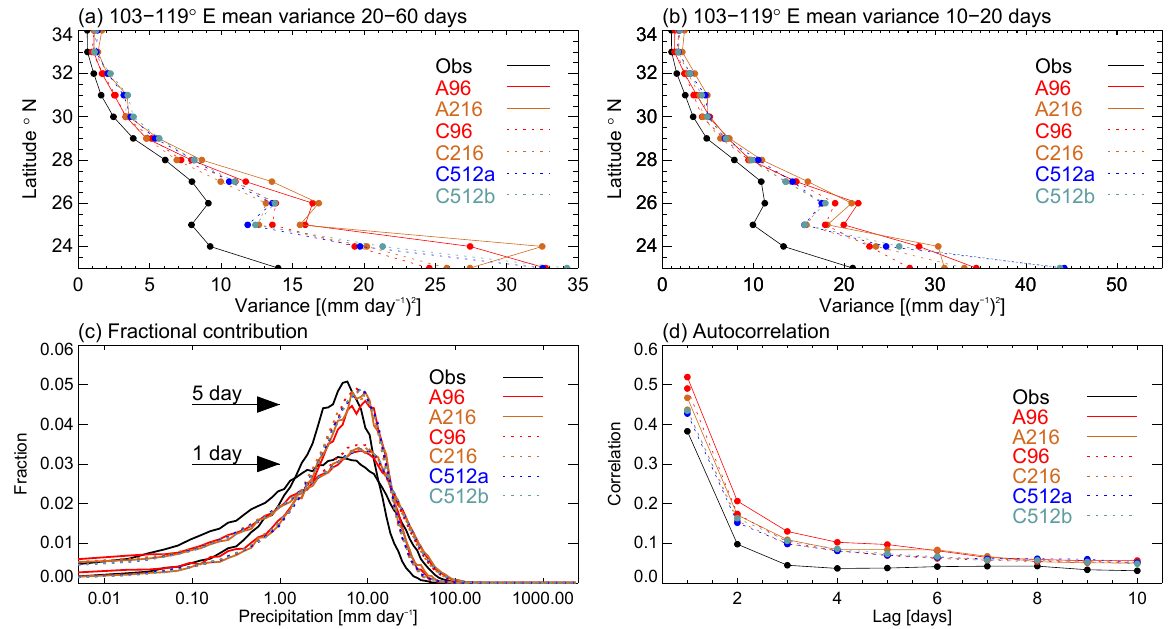
Figure 5. (a, b) Observed and simulated meridional profiles of the intraseasonal variance of precipitation averaged between 103 and 119 ◦ E for (a) 10–20-day and (b) 20–60-day filtered variability. (c, d) For precipitation averaged over southern China (22–32 ◦ N, 103–119 ◦ E) the (c) observed and simulated spectra of fractional contributions to daily and 5-day precipitation totals and (d) autocorrelations of daily precipitation at different time lags averaged over southern China (22–32 ◦ N, 103–119 ◦ E). Details on the computations are given in Sect.